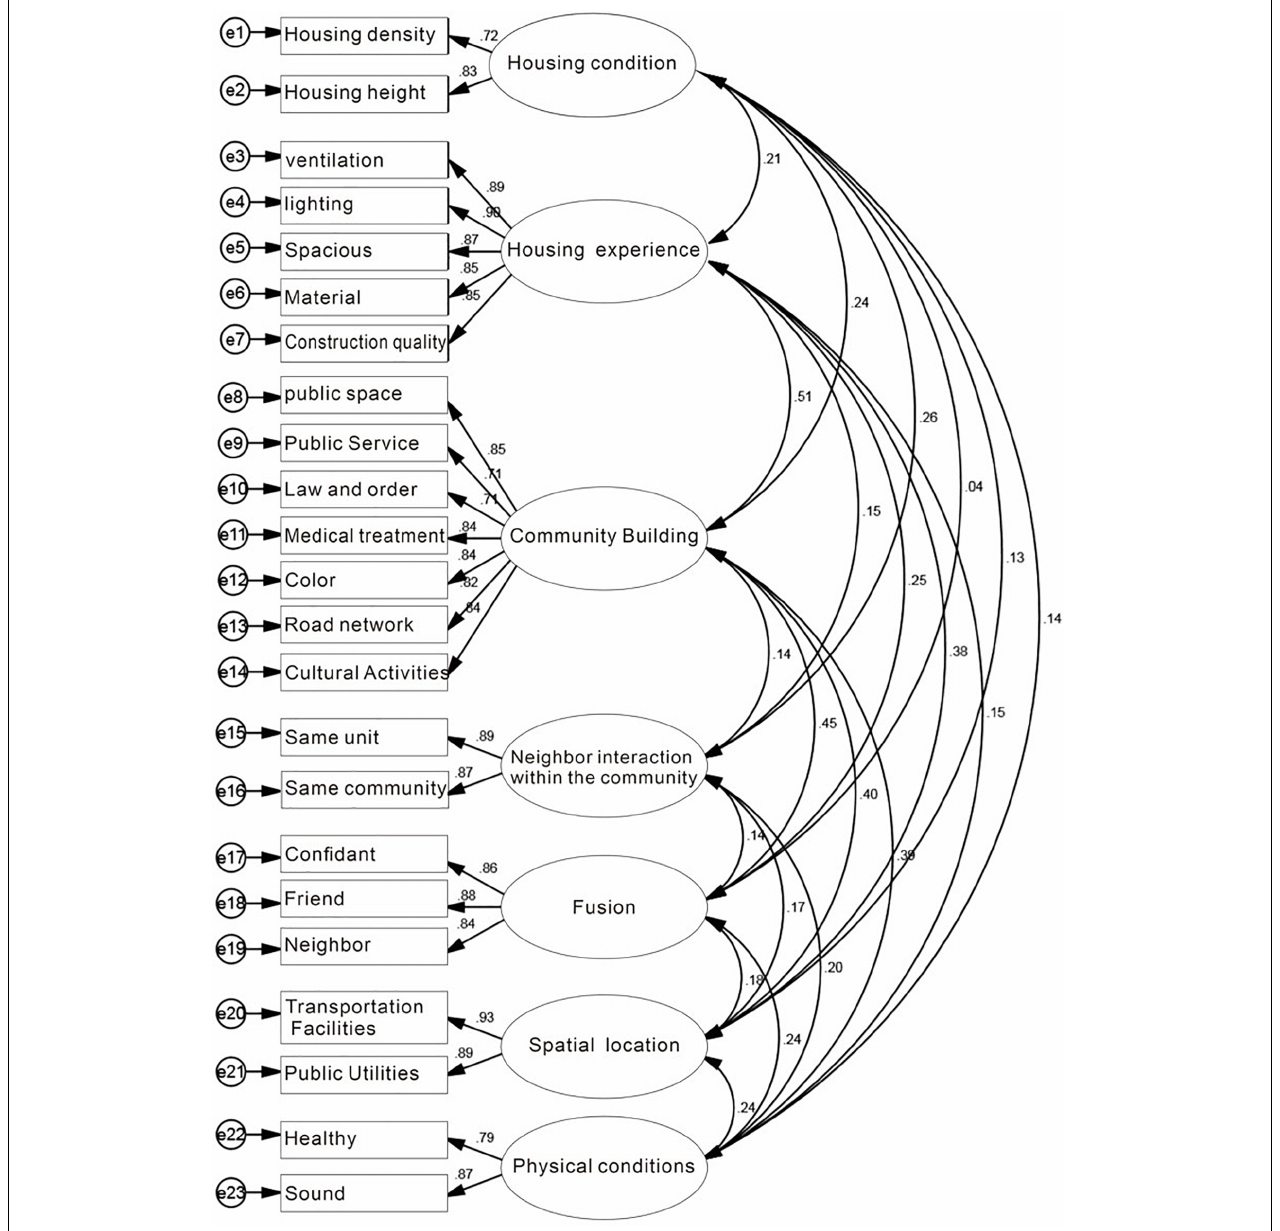
FIGURE 5 | Diagram of the confirmatory factor